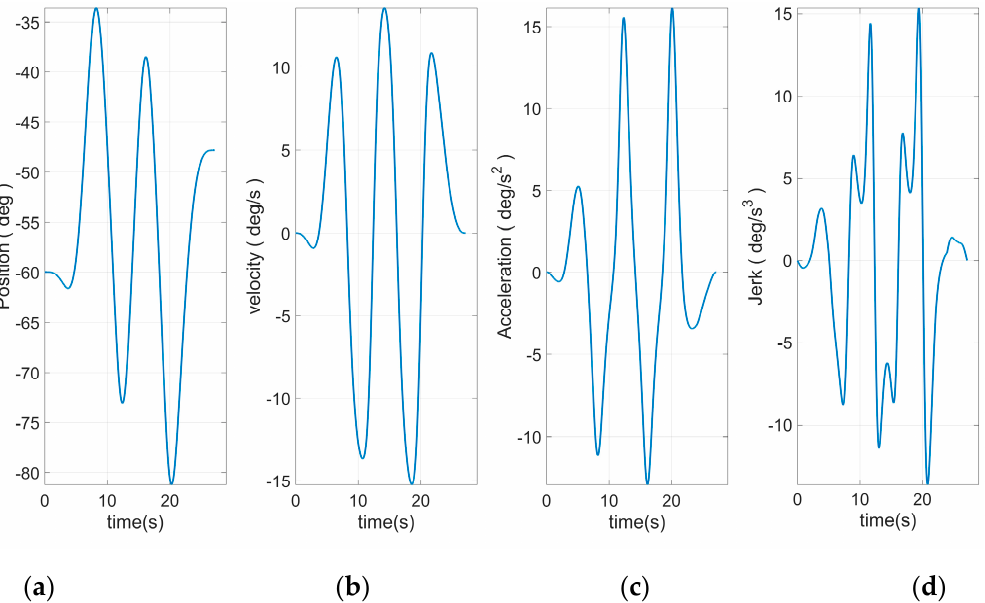
Figure 12. (a) Displacement of axis II over time. (b) Velocity of axis II over time. (c) Acceleration of axis II over time. (d) Jerk of axis II over time. Figure 12. ( a ) Displacement of axis II over time. ( b ) Velocity of axis II over time. ( c ) Acceleration of axis II over time. ( d ) Jerk of axis II over time.